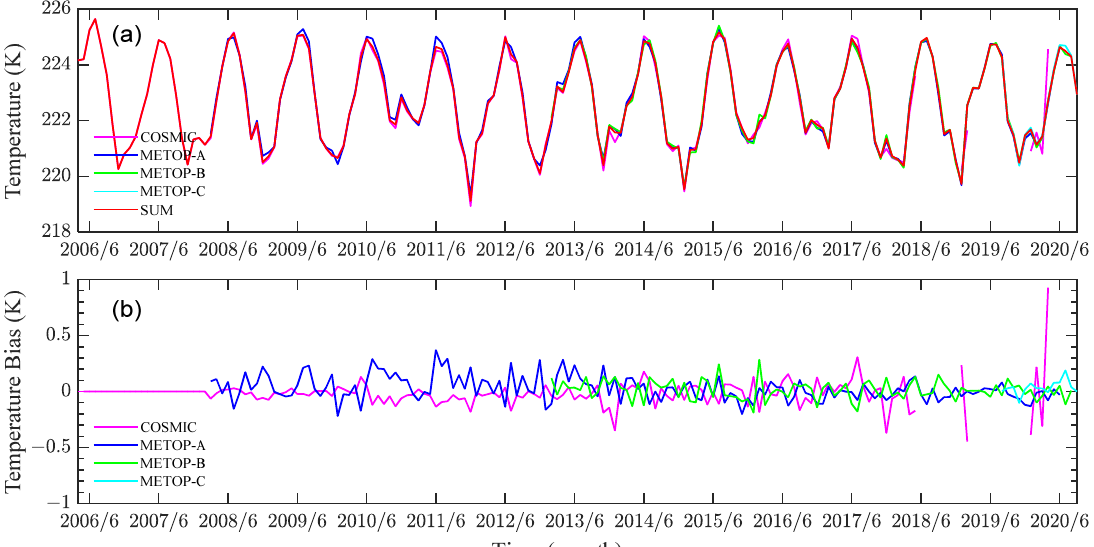
Figure 2. The monthly average of ( a ) temperature and ( b ) the temperature bias variation of 8~38 km around TP (20~50 ◦ N, 60~120 ◦ E) from May 2006 to September 2020. Magenta solid line, the COSMIC temperature; blue solid line, the METOP-A temperature; green solid line, the METOP-B temperature; cyan solid line, the METOP-C temperature; red solid line, the combined temperature.